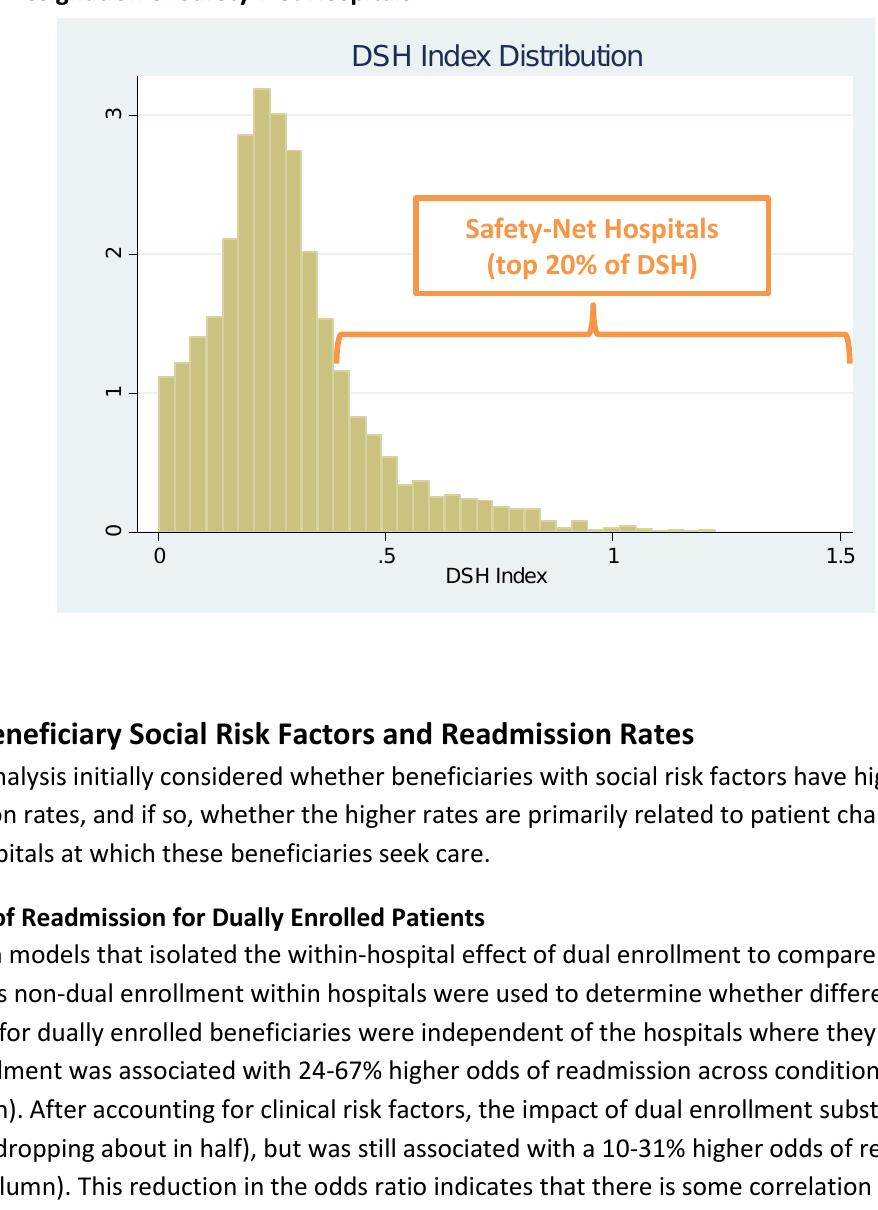
Figure 5.2. Designation of Safety-Net